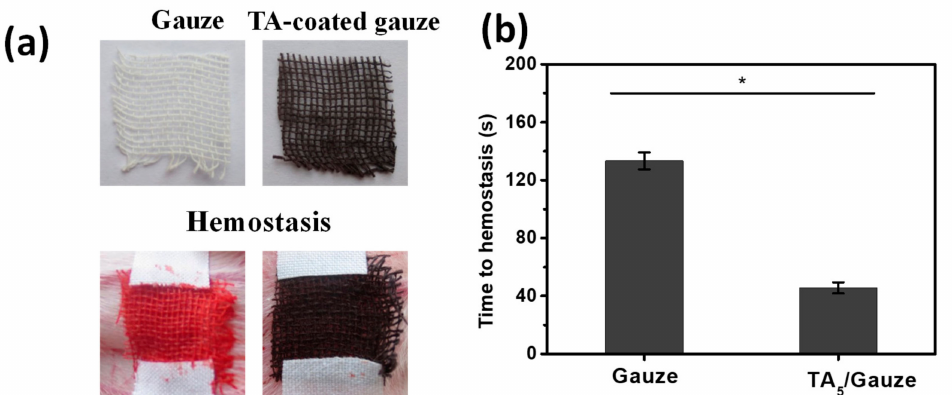
Figure 6. Clotting time comparison of the untreated gauze and TA-coated gauze on an animal wound. ( a ) Digital images of the gauze and TA-coated gauze as hemostatic dressing (top) and the application to the wound of base vein in a rabbit ear model (bottom); ( b ) Time to hemostasis of the untreated gauze and the TA-coated gauze. Mean ± SD. Statistical analysis was performed with the Student’s t-test, *: p <